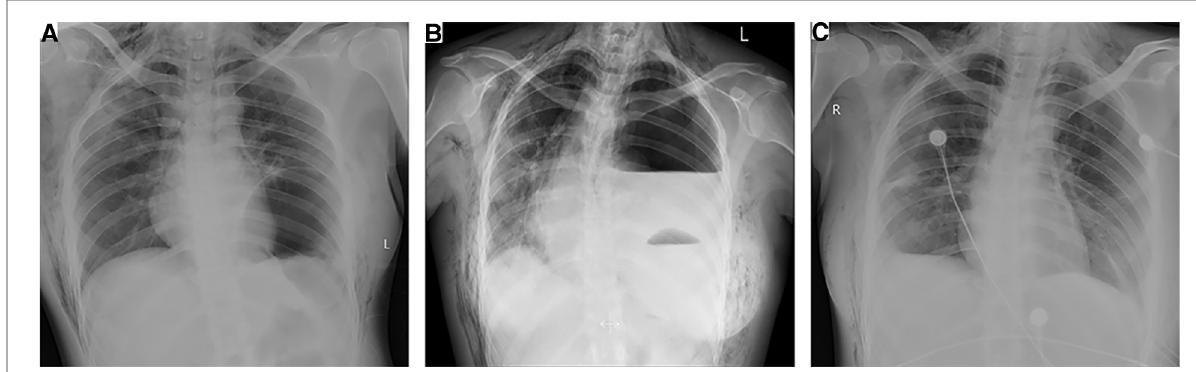
FIGURE 1 Chest radiographs. ( A ) Initial chest radiograph revealing an elevated left hemidiaphragm and pneumothorax in the left lung. ( B ) Chest radiograph showed left pleural effusion and a mediastinal shift toward the right with an elevated left hemidiaphragm. ( C ) Postoperative chest radiograph revealed normal positions of the stomach bubble and diaphragmatic contour.